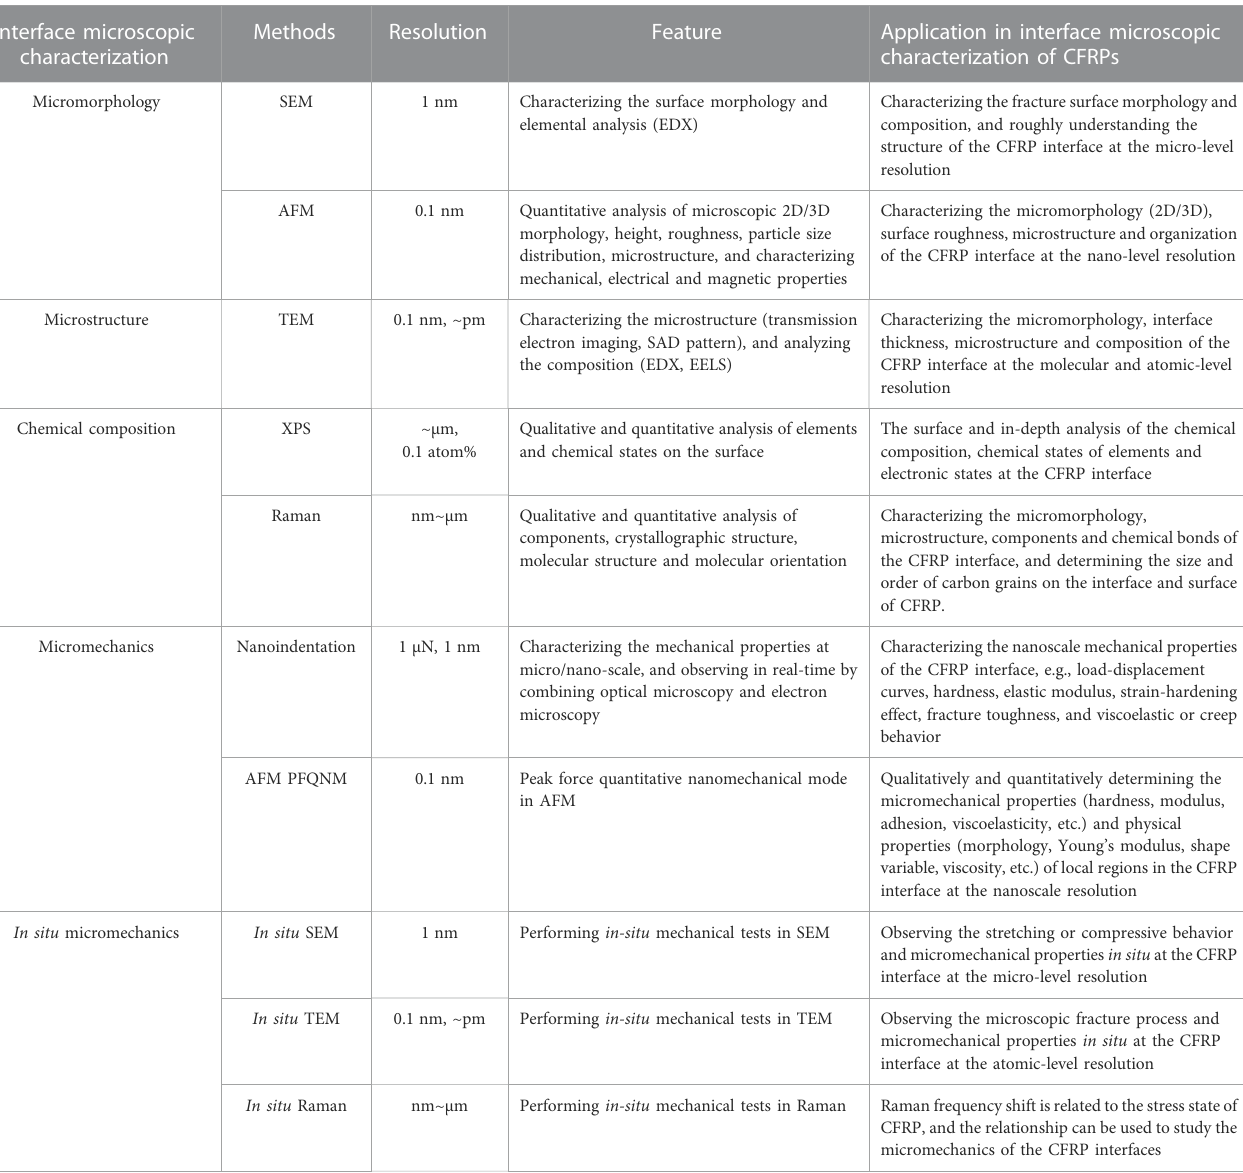
TABLE 1 Interface microscopic characterization methods of